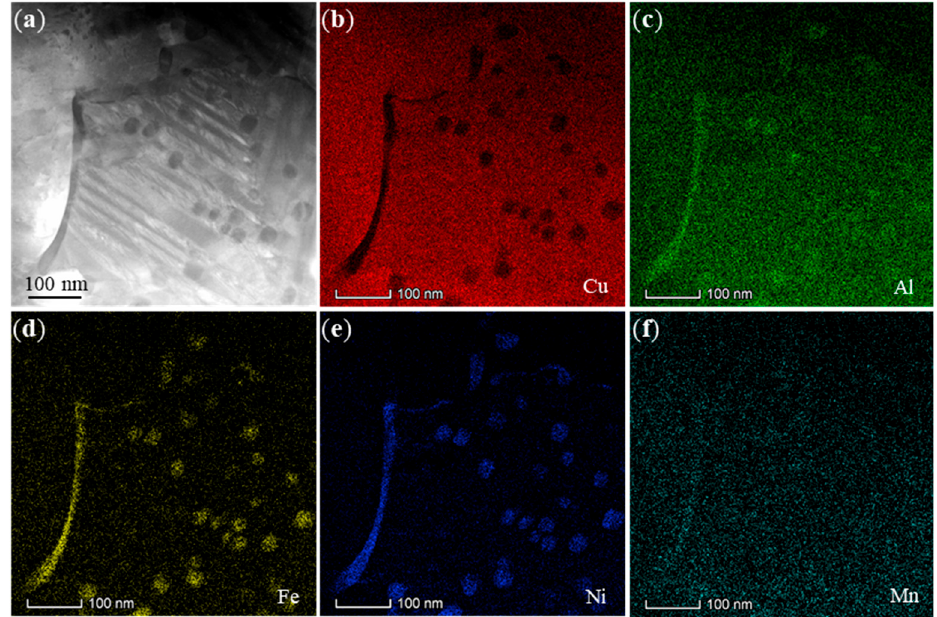
Figure 12. ( a ) HAADF image of the UVA treatment WAAM in the twinning region, ( b – f ) corresponding EDS elemental maps for Cu, Al, Fe, Ni, and Mn, respectively. The lamellar precipitates are NiAl ( κ III ), and globular Fe 3 Al ( κ II ).